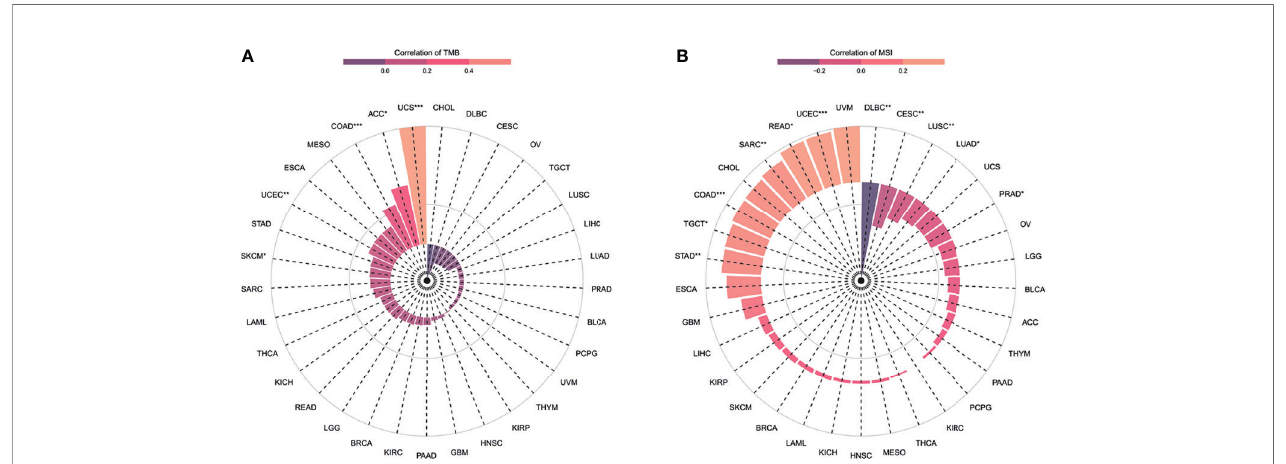
FIGURE 6 | The correlation between ANXA2P2 expression and immunotherapeutic markers. (A) TMB and (B) MSI in pan-carcinoma. *P < 0.05, **P < 0,01 and ***P < 0.001.